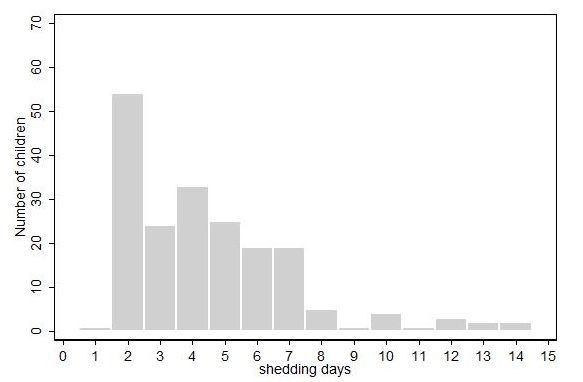
Frequency of duration of RSV shedding.